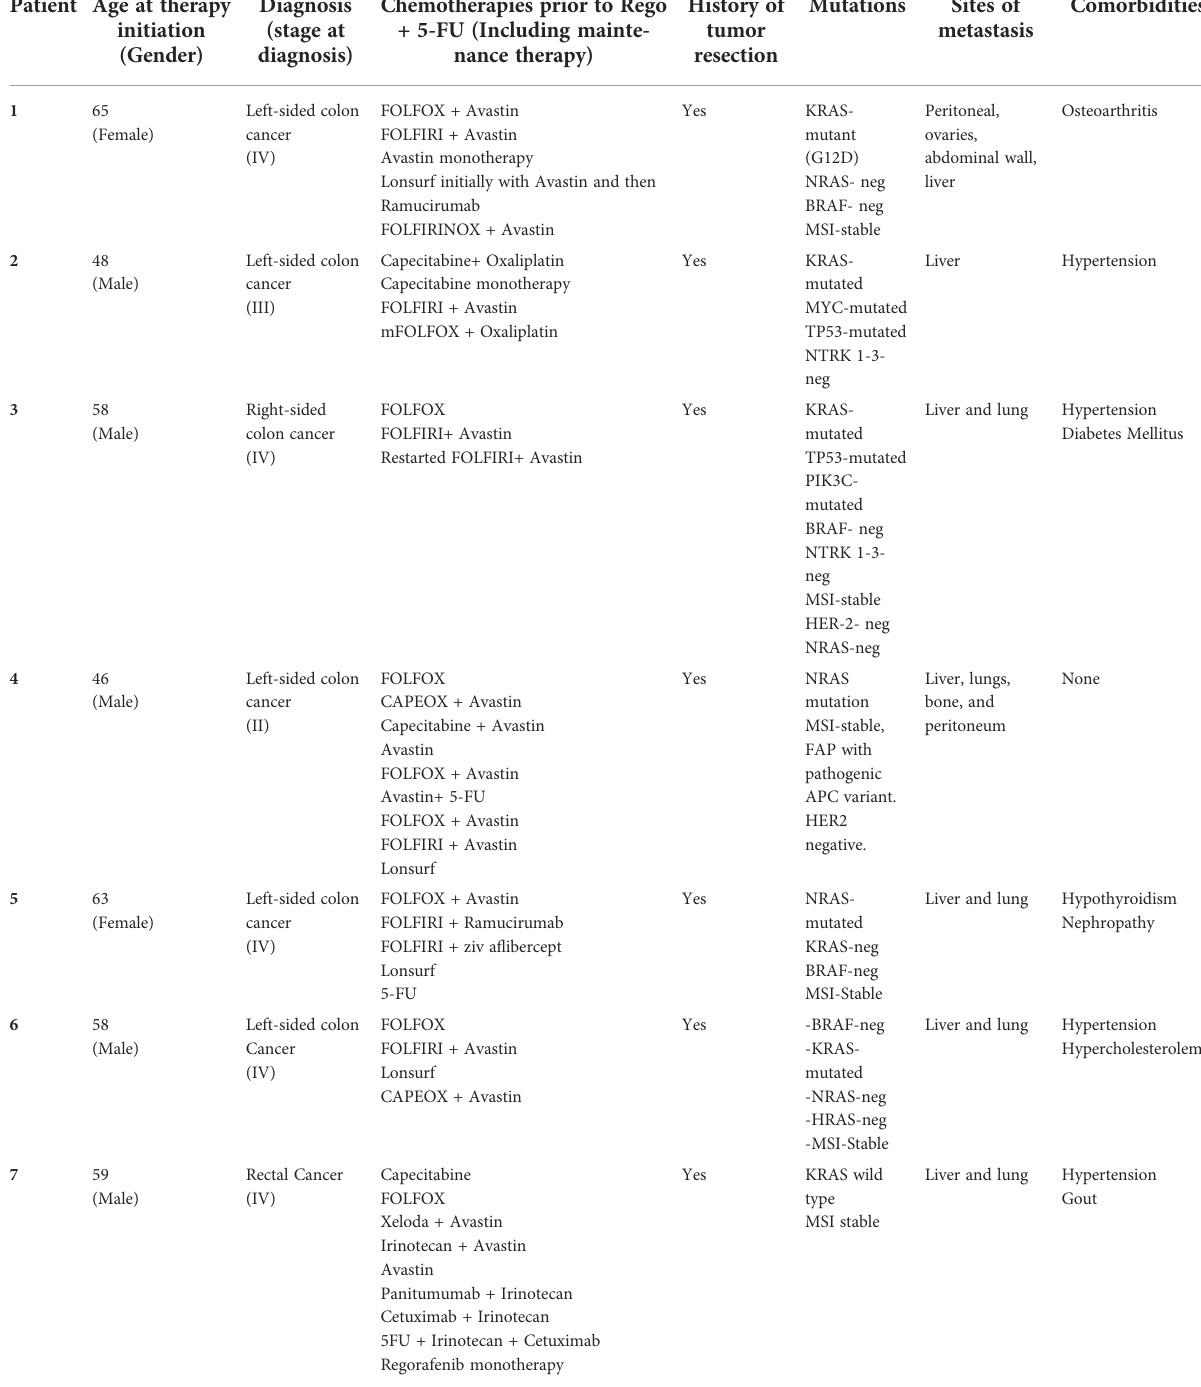
TABLE 1 Basic characteristics of the included patients. Patient Age at therapy